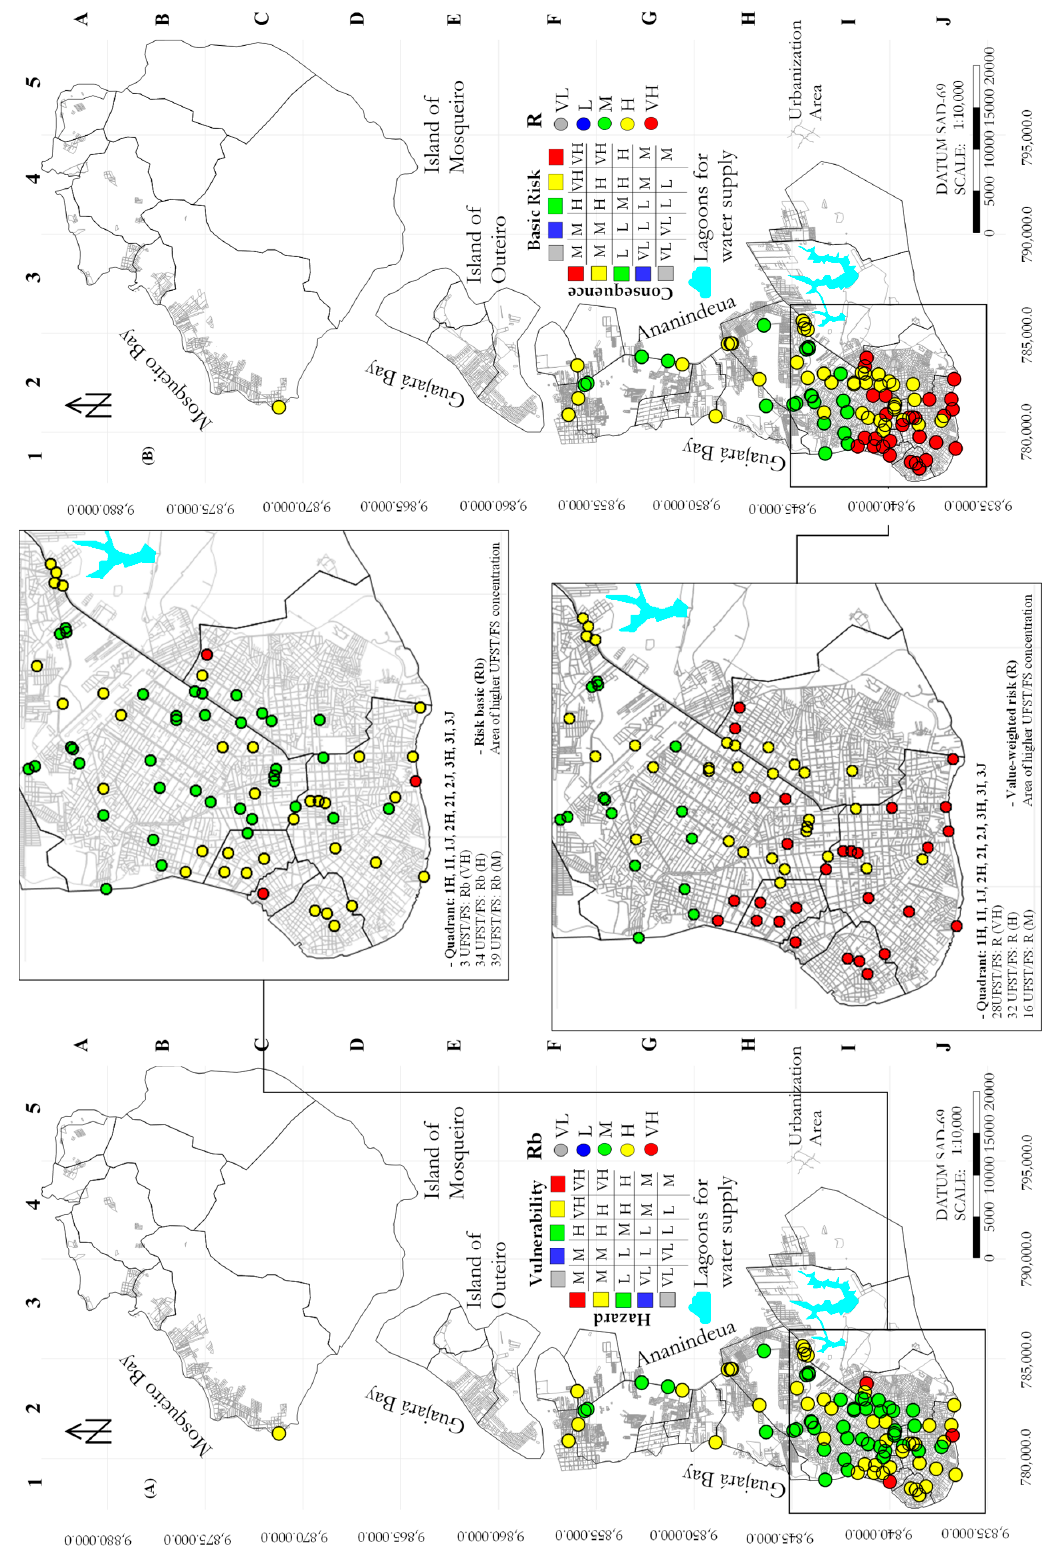
Figure 7. ( A ) Basic risk of contamination ( R b ); ( B ) value-weighted risk ( R ).